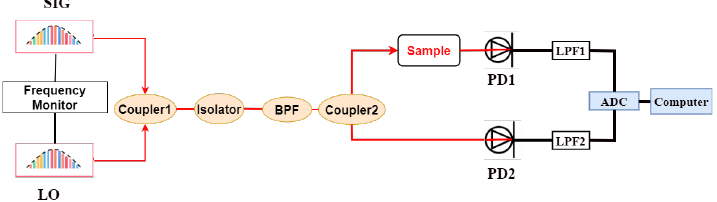
Figure 2. Diagram of the DCS system.